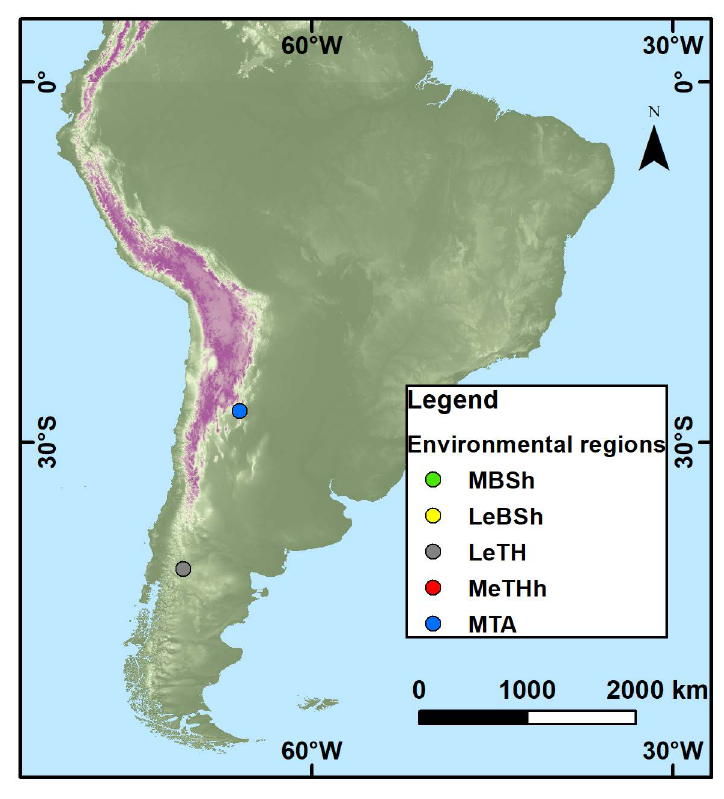
Figure 8. Geographic localization of the two South American watersheds included in the